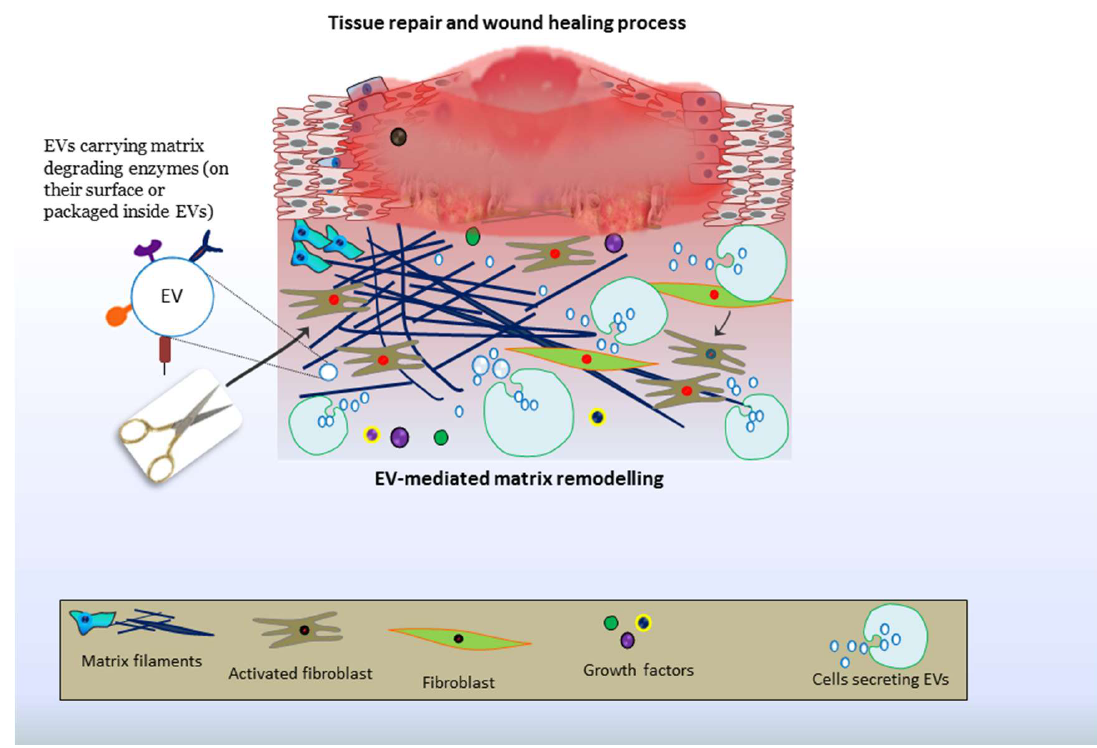
Figure 2 . Schematic illustration for the roles of EV-associated MMPs in tissue repair: EV-associated matrix modeling enzymes stimulate the repair processes through matrix remodeling .